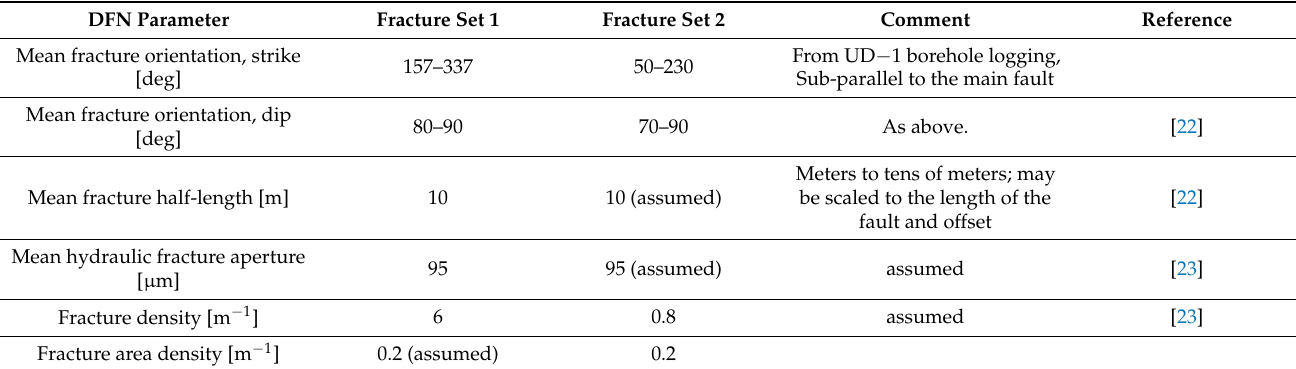
Figure 6. Pressure and flow rates of the four days of hydraulic testing/stimulation operation per- formed in UD − 2 from 17th to 20th November 2020. Due to confidentiality, exact flow rate and pressure values are hidden and are shown only in terms of multiplication of x . Table 2. DFN characteristics within the fault Table 1. DFN characteristics of host rock zone.